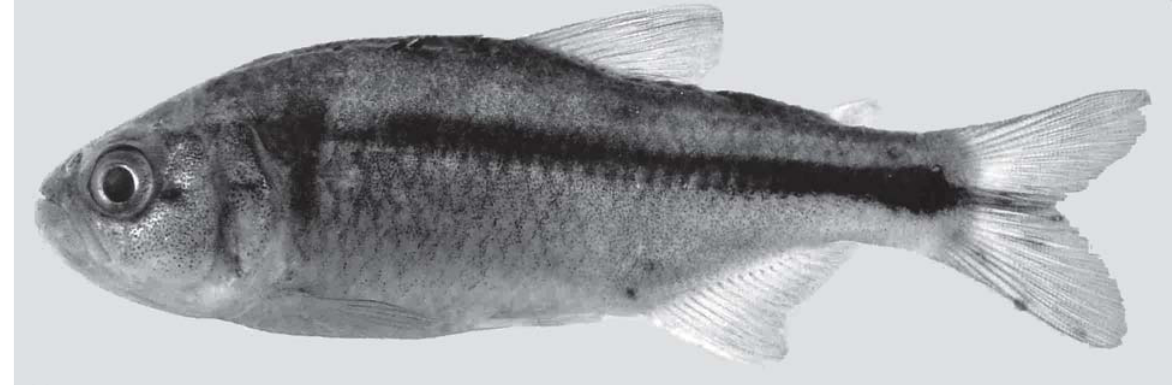
Fig. 2. Astyanax totae , holotype, MHNCI 10305, 61.1 mm SL, rio Cascata, tributary of rio Tortuoso, an affluent of the rio Iguaçu.